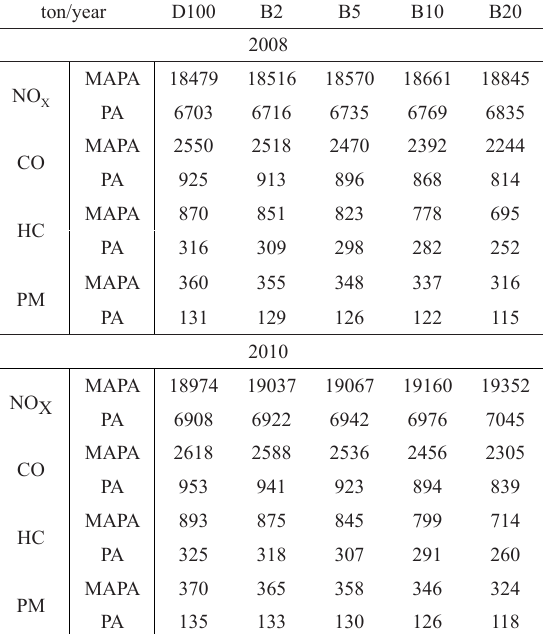
blends for the vehicles on the road in 2008 and 2010 in Porto Alegre (PA) and in the MAPA.